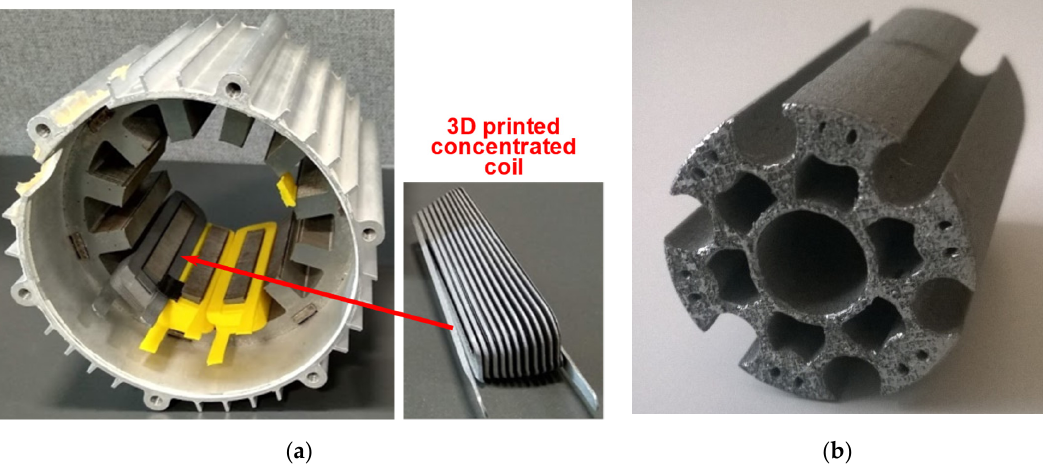
Figure 16. SRM components fabricated using AM technologies. ( a ) 3D ‐ printed concentrated coil placed on the stator poles [90], reproduced with permission from the owner, Silbernagel, C.; ( b ) optimized 3D ‐ printed SRM rotor [32], reproduced with permission from the owner, VTT Technical Research Centre of Finland.